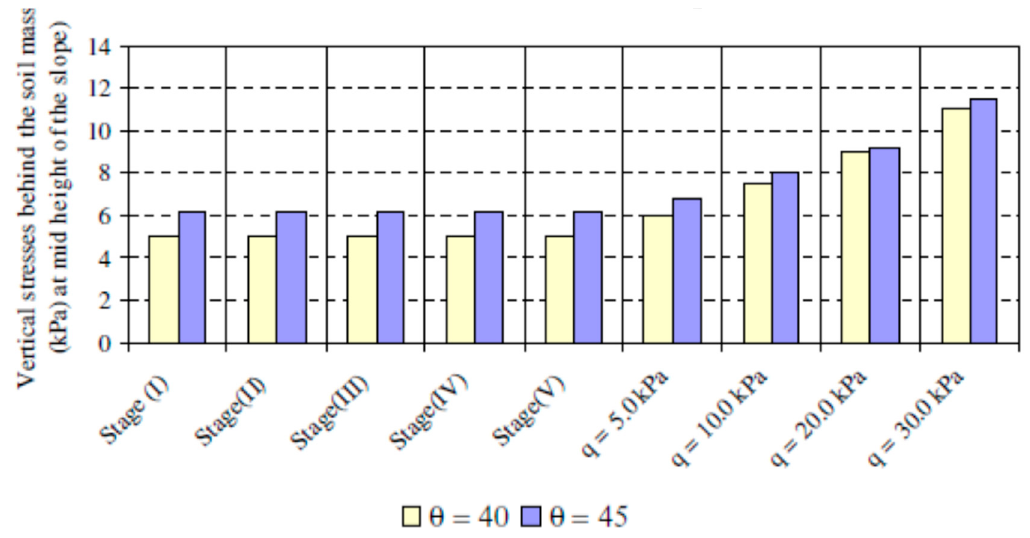
Figure 18. Influence of nail inclination on vertical stresses behind the nailed soil mass at mid-height of slope.